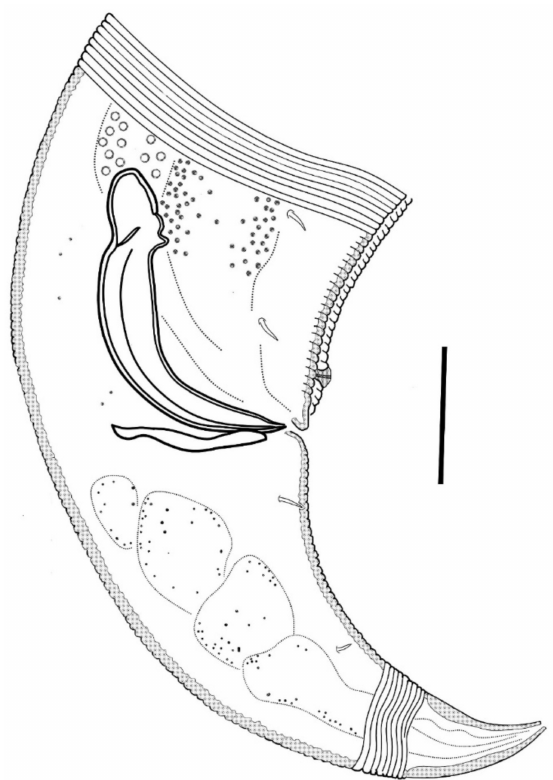
Figure 9. Acanthopharynx micans , male tail (sample PA13, sponge Cinachrya sp.). Scale bar 20 µ